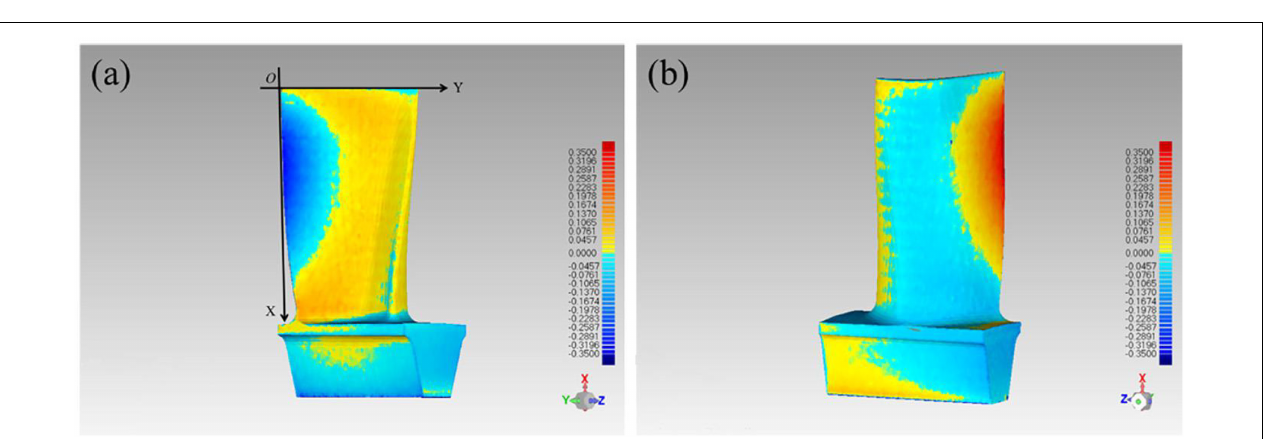
Frontiers in Materials |